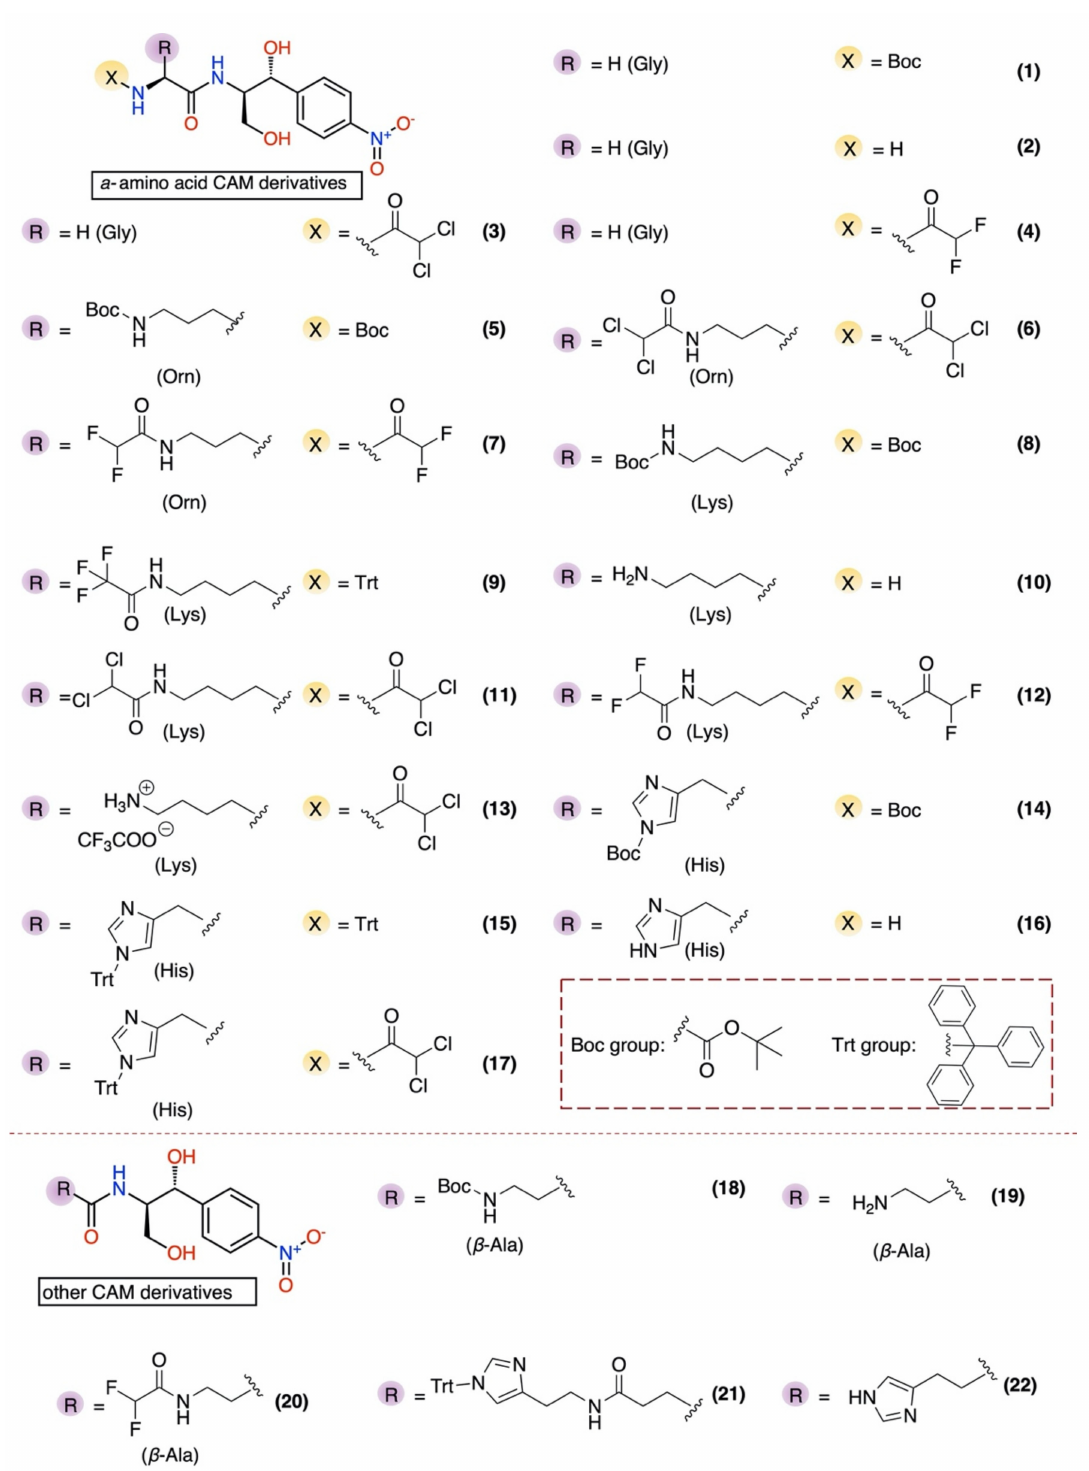
Figure 2. Structures of CLB derivatives encountered in this work. According to the in vivo and in vitro evaluation of all new compounds, the bis- dichloroacetyl derivative of ornithine (6) (Figure 2) displayed the highest antimicrobial activity in vivo and in vitro and appears to be a dynamic new pharmacophore with room for further modification and